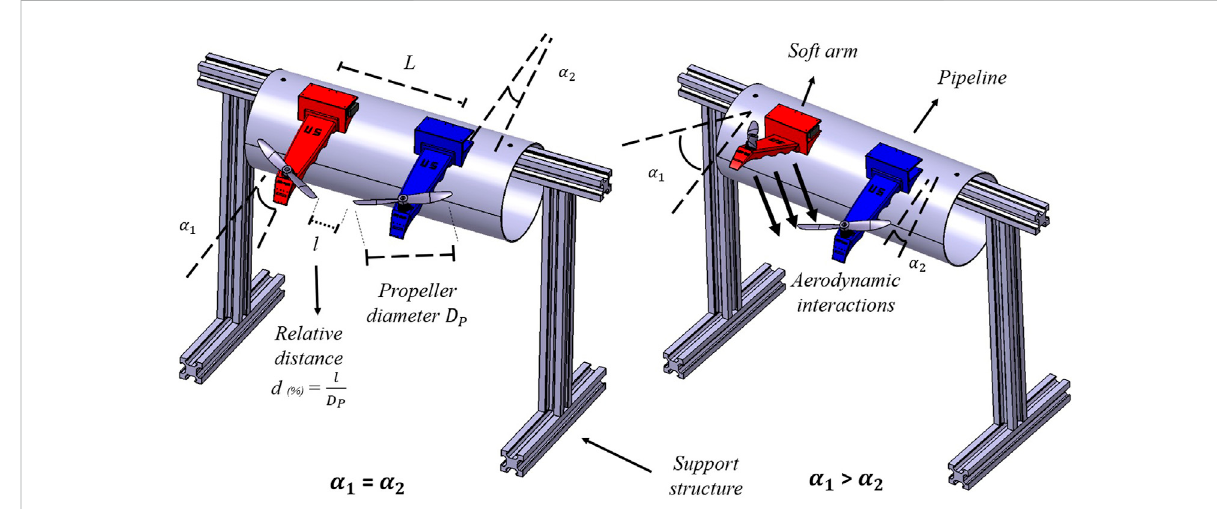
FIGURE 2 CAD model of the test bench used to analyze aerodynamic interferences between the arms and tuning of the PID controllers for hovering conditions.